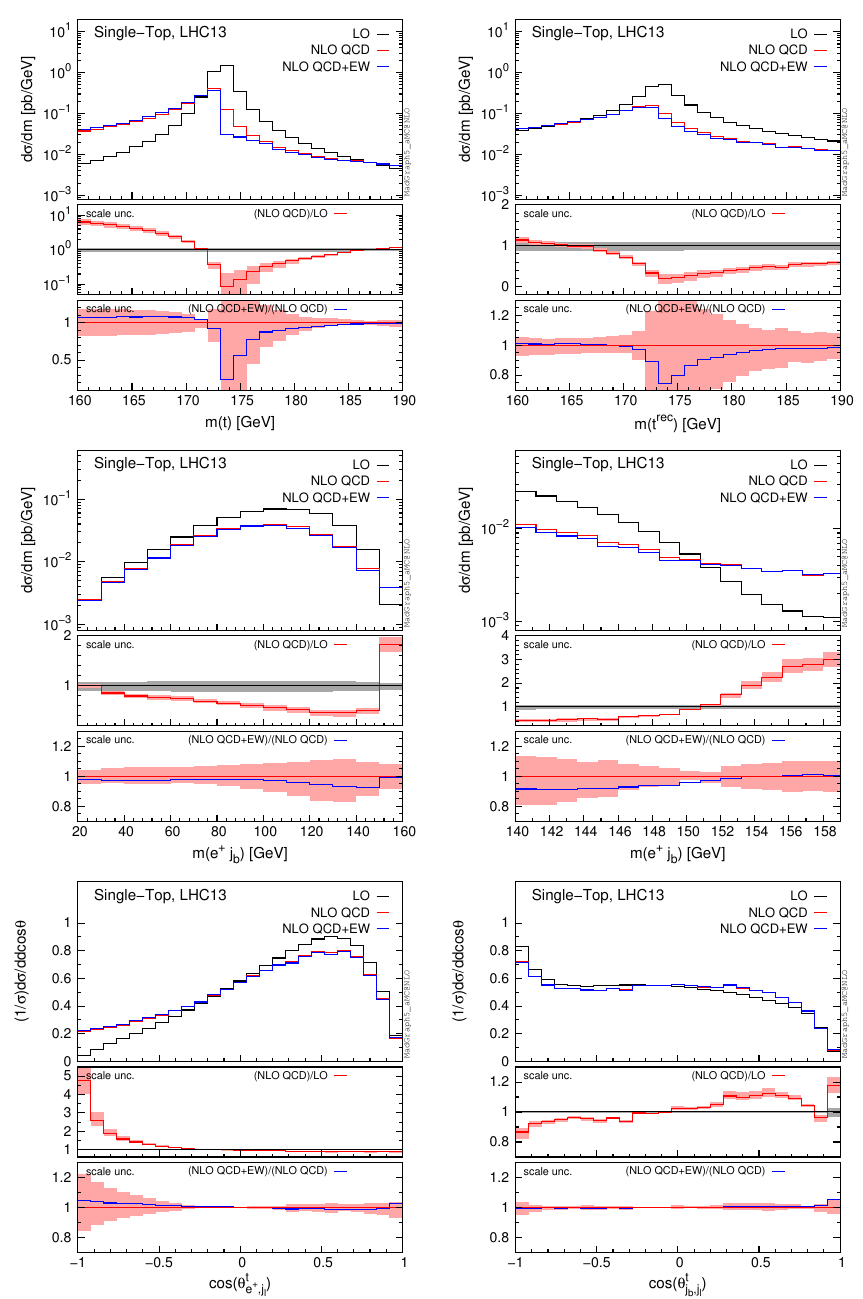
Figure 3 . LO, NLO QCD and NLO QCD+EW predictions for the top-quark invariant mass (top) at the truth level (left) and reconstructed (right), positron and b -jet system invariant mass distribution (central) in a large (left) and small range (right), and spin-correlation observables (bottom) for the Single-Top process.